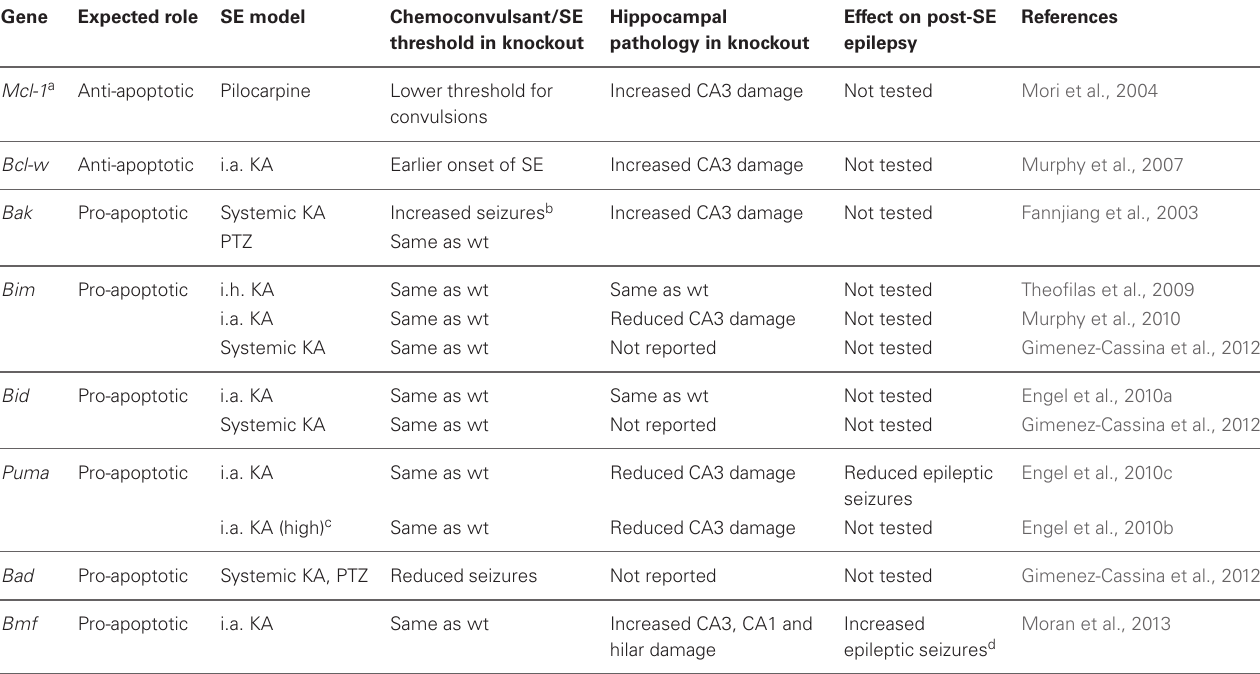
Table 1 | Summary of effects of genetic disruption of Bcl-2 family proteins on status epilepticus-induced neuronal death and post-status epilepsy in